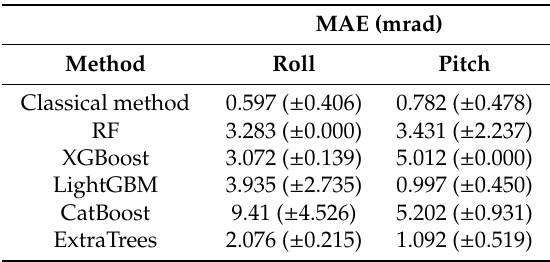
Table 9. Wide range experiment with new angle after 1 s.